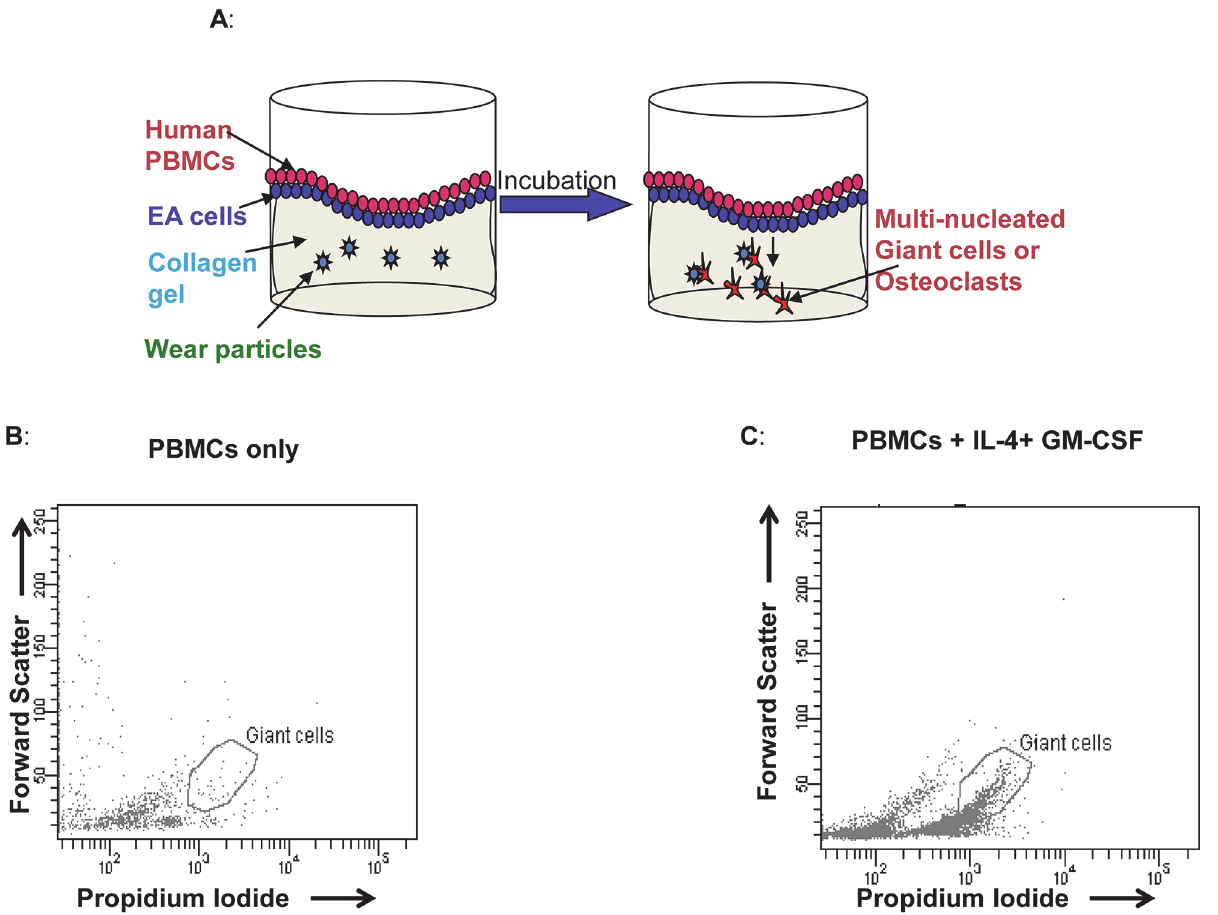
Fig 1. Development of Peripheral Tissue-Equivalent Model using collagen gel / EA Hy926/ PBMCs and characterization of MGCs by flow cytometers. A) For the 3-D peripheral tissue equivalent model, particles were added at the time of collagen gel polymerization. Endothelial cells (EA, EAHy926 cell line) were grown on the top of the collagen gel to form a monolayer. One million peripheral blood mononuclear cells (PBMCs) were seeded on top of the endothelial cell monolayer and incubated for 2 weeks. MGCs or OCs were characterized and quantified on flow cytometer. Collagen gels were polymerized as described in method One million peripheral blood mononuclear cells (PBMCs) were treated without (B) or with (C) cytokines IL-4 and GMCSF for two weeks. Cells were harvested by digesting the gel with Collagenase. Cells were washed, fixed and permeabilized using BD cytofix/ perm buffer, and stained with propidium iodide before acquisition on a flow